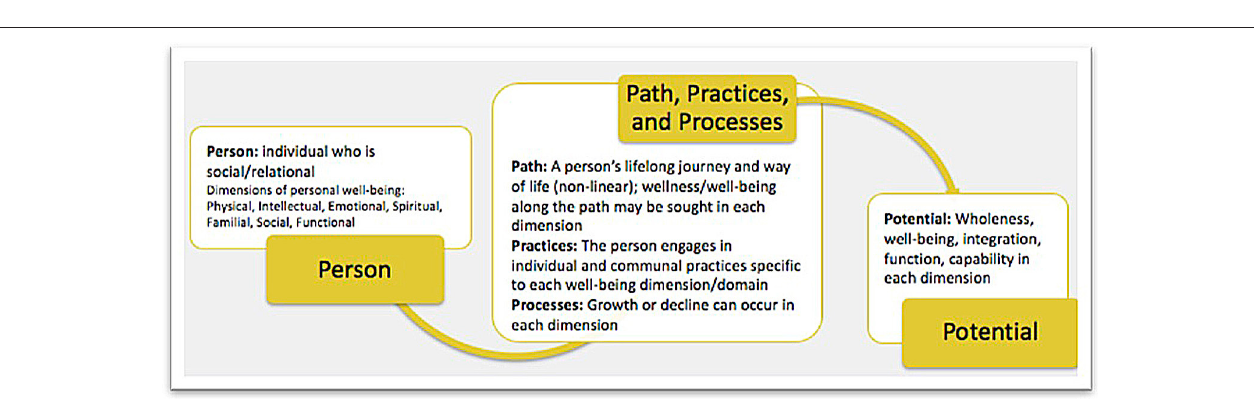
FIGURE 2 | The 5 Ps: personal paths, practices and processes to maximizing